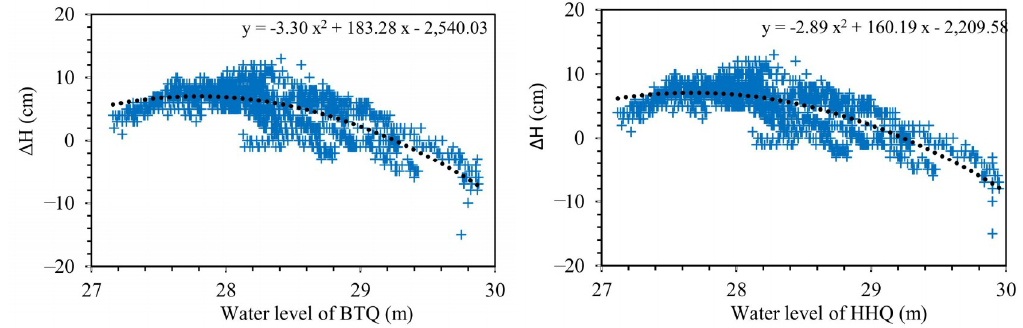
Figure 10. The water level difference between BTQ and HHQ. (ΔH = L BTQ − L HHQ , L BTQ is the water level of BTQ and L HHQ is the water level of HHQ.